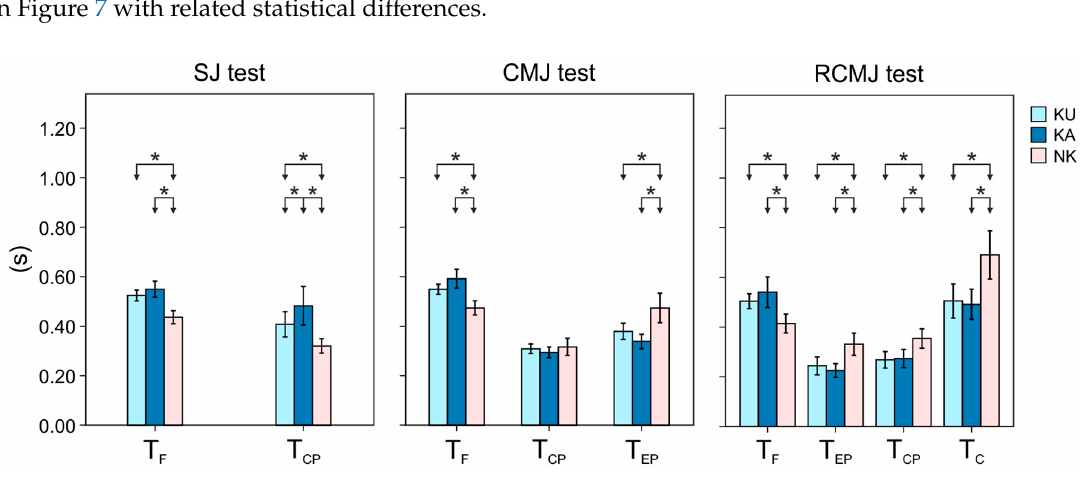
Figure 7. Mean values and standard errors of the parameters related to the jumping tests. From left to right: Squat Jumps (SJ), Countermovement Jumps (CMJ), and Repeated Countermovement Jumps (RCMJ) tests. Parameters: Flight Time (T F ), Concentric Phase Time (T CP ), Eccentric Phase Time (T EP ), and Contact Time (T C ). KU, KA, and NK stand for kumite, kata, and control group, respectively. * indicates statistical di ff